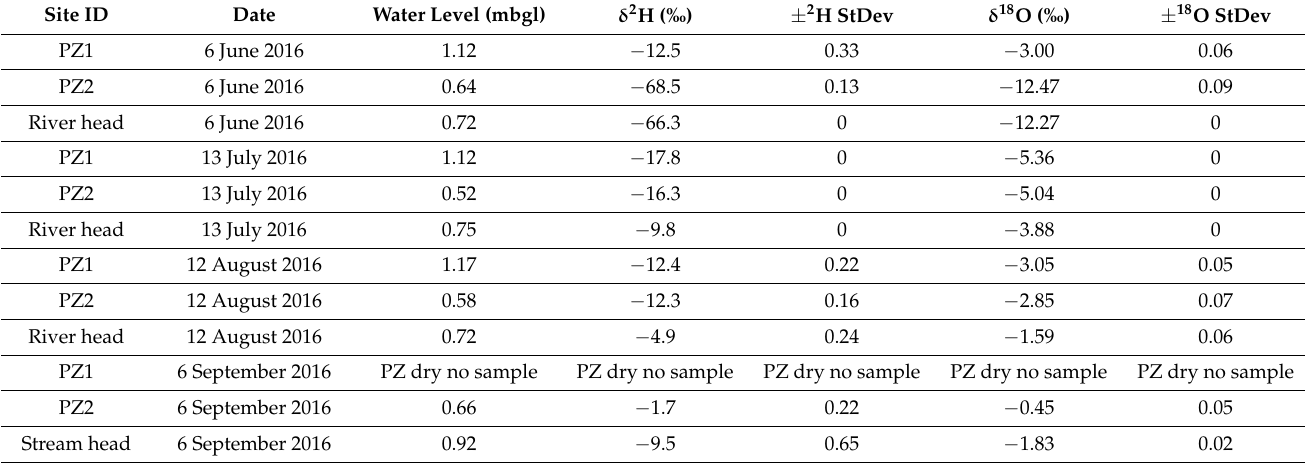
Table 4. Stable isotope and water level data for the piezometers and the stream.